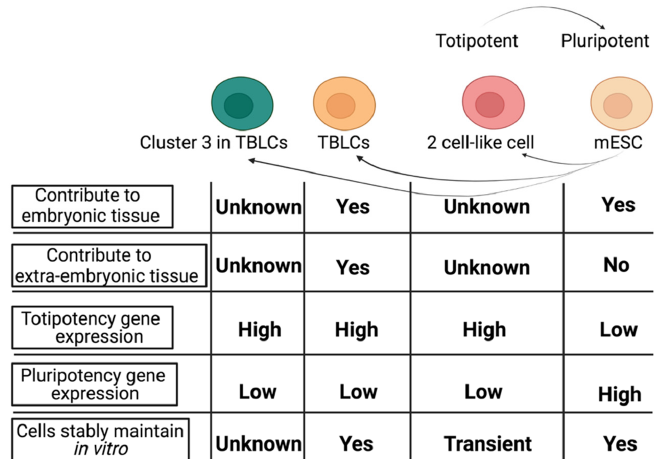
Figure 1. Comparison of molecular and functional features between ESCs, TBLCs, cluster 3 TBLCs, and 2-cell-like cells.